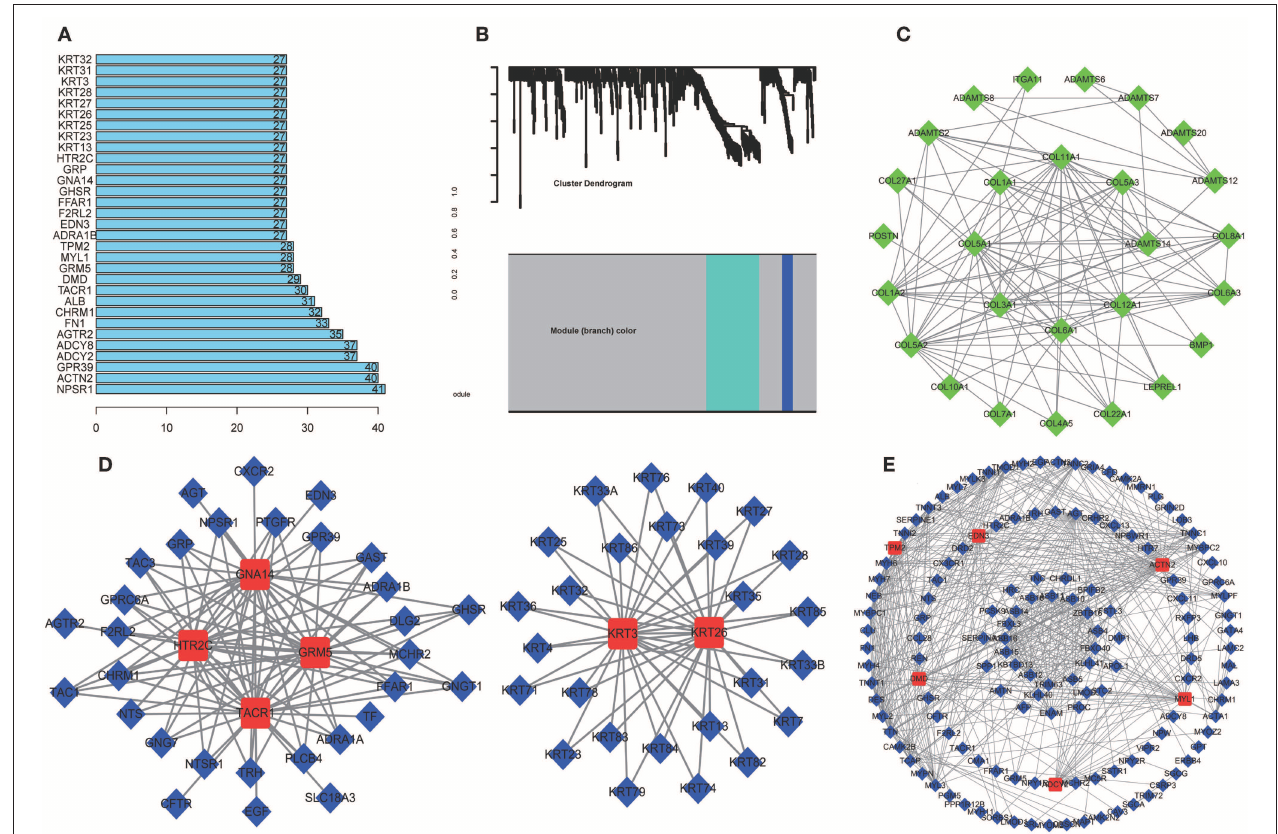
FIGURE 3 | Protein-protein network (PPI) based on the DEmRNAs with a combined score was > 0.90. (A) 31 hug genes were listed because the degree was > 25 in the PPI network. (B) Module analysis of DEmRNA enrolled in PPI network with the criterion cut. Height = 0.8, min size = 10. Same color means it belongs to the same module. And 3 modules were visualized in Cytoscape (C–E) . The connection between the nodes indicates the potential interaction between different mRNA, and red represents the hub gene in the PPI network. Meanwhile, GO and KEGG analysis of 3 modules was performed in DAVID ( Tables 1 – 3 ).